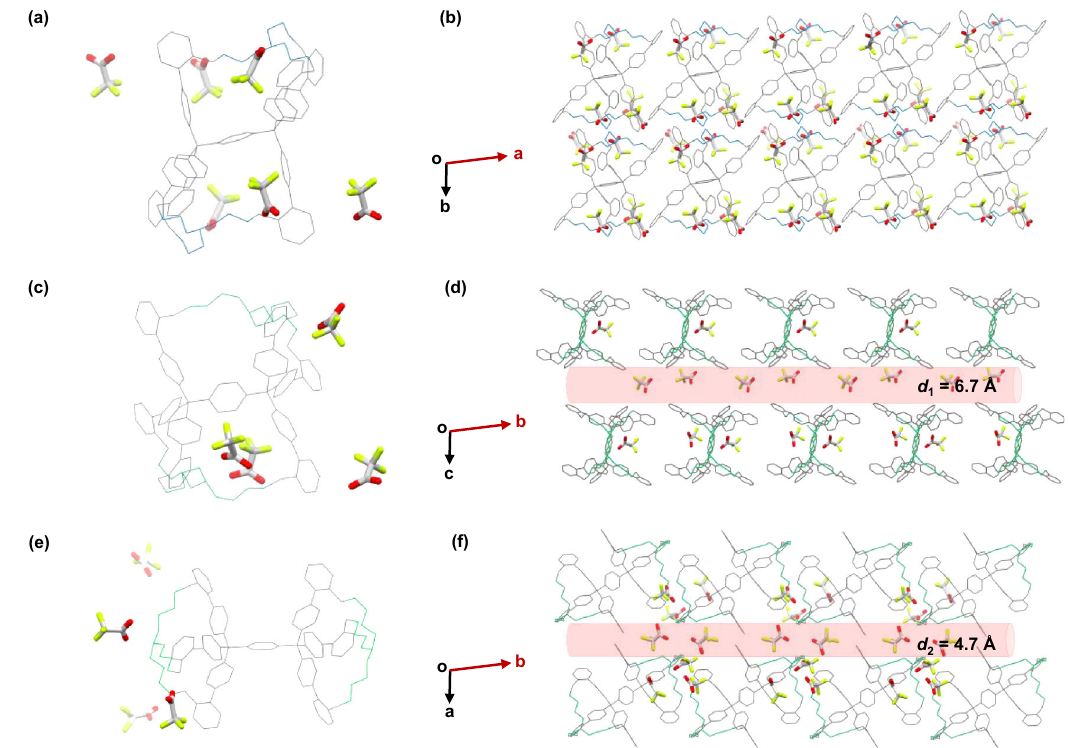
Fig. 7 The comparison of the molecular structure of three diphanes with the presence of TFA, their self-assembled superstructures with different proton-conducting channels. Molecular structures of a endo -[1,2,4]diphane, c endo -[1,2,5]diphane, and e exo -[1,2,5]diphane determined by SC-XRD, and their corresponding superstructures shown in b , d , and f . b Tri fl uoroacetic acid (TFA) molecules are trapped within the windows of endo -[1,2,4]diphane, whose superstructures exhibit no intermolecular channels. The intermolecular channels highlighted in red are present in the superstructures formed by d endo -[1,2,5]diphane and f exo -[1,2,5]diphane, respectively, providing the mobility of TFA molecules. TFA molecules are highlighted with bold stick model, with fl uorine atoms labeled in green, oxygen in red, and carbon in gray. Table 1 The proton conductivity ( σ ) of diphanes – TFA at 303 and 333 K, and their corresponding activation energy ( E a ) at a relative humidity of